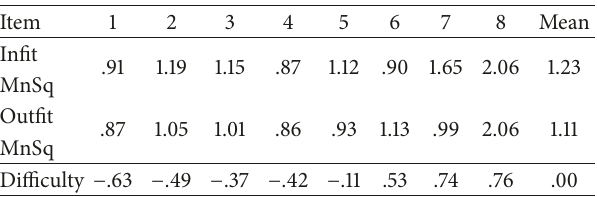
Table 1: Internal validity of the MCPSAT by item relevance indexes and item difficulty